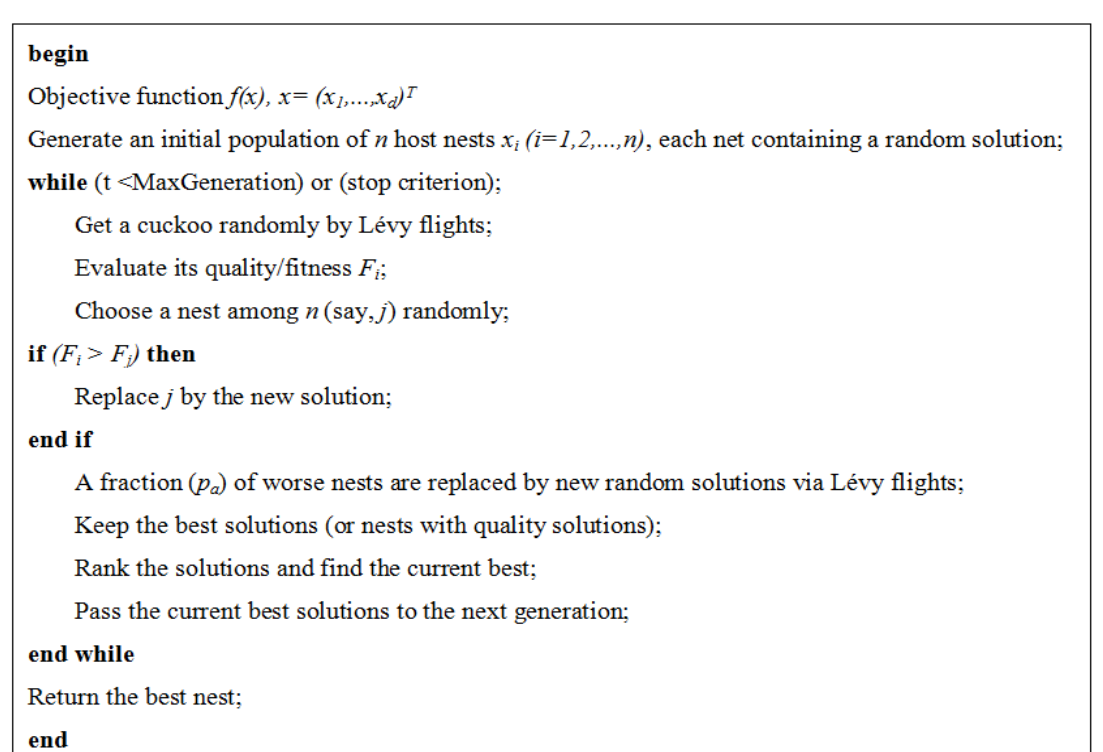
Figure 1. Pseudocode of the Cuckoo Search